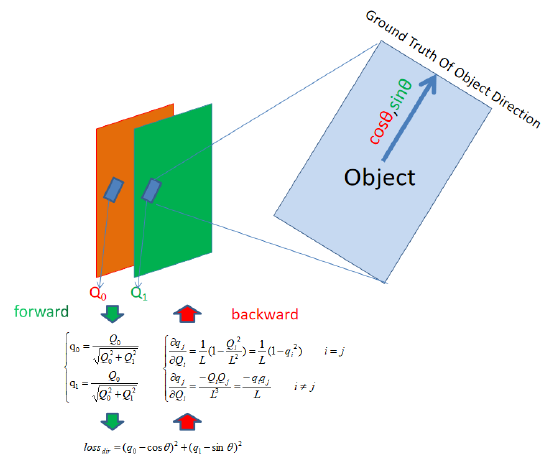
Figure 4. Forward and backward of the object direction calculation.